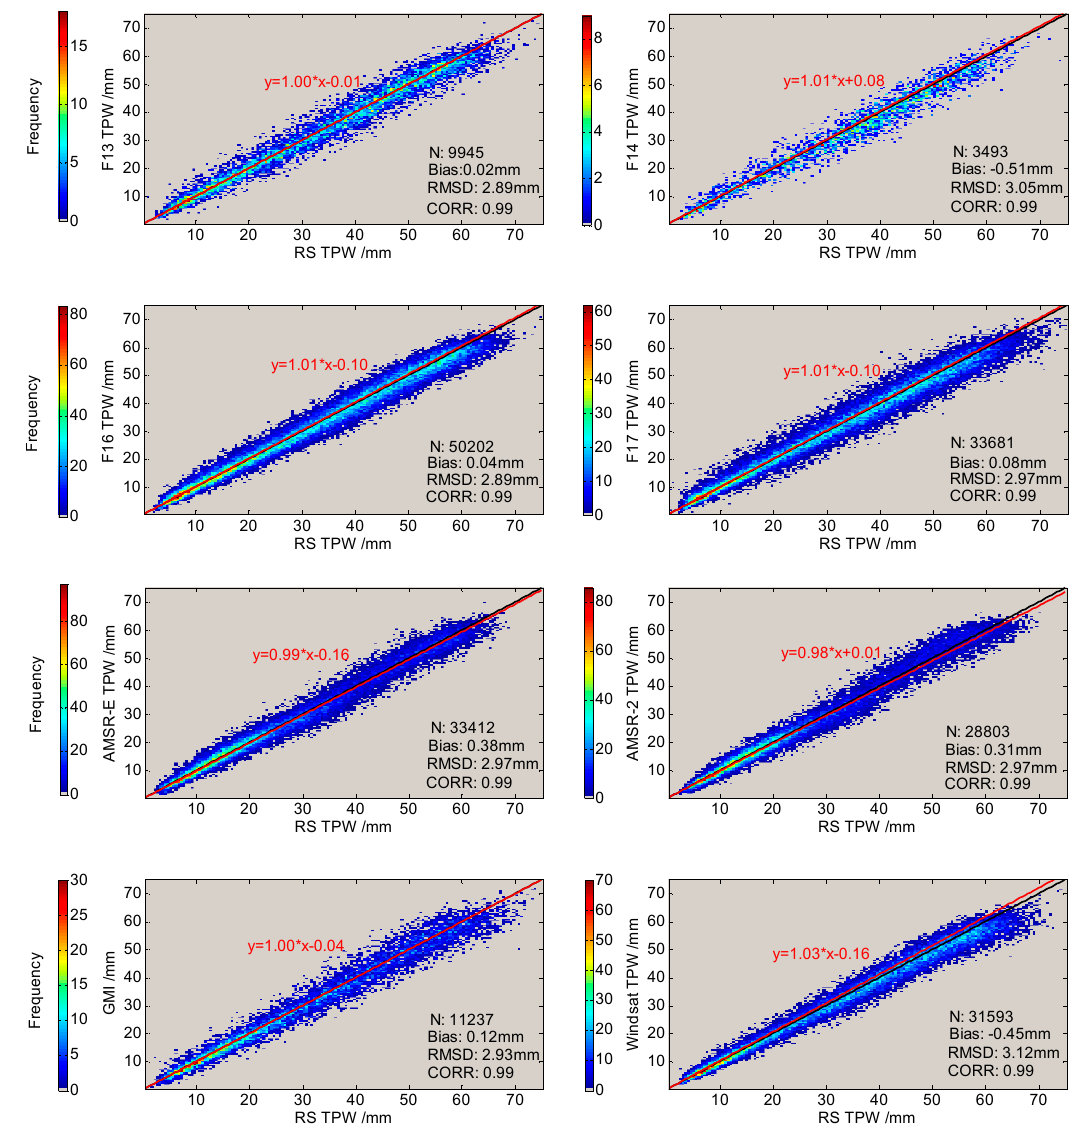
Figure 5. Scatter plots of coincident TPW measurements of the satellites and radiosonde.